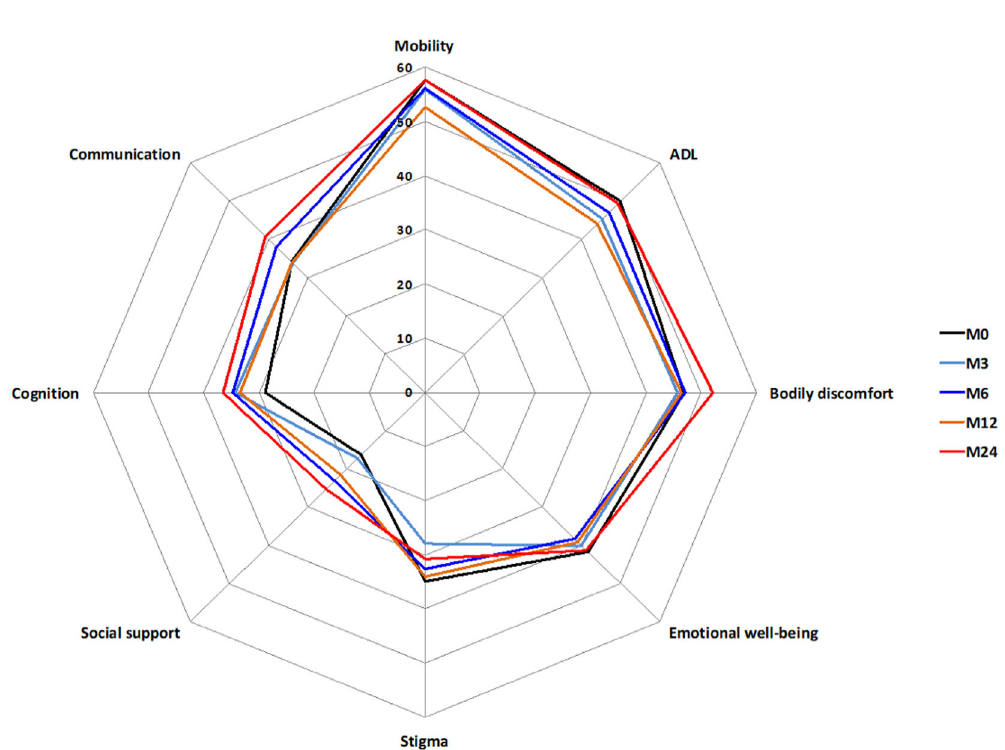
Fig. 2 Comparison of HRQoL measured by PDQ-39. The evolution of each dimension of PDQ-39 at baseline (M0) and at each follow-up visit (M3, M6, M12,